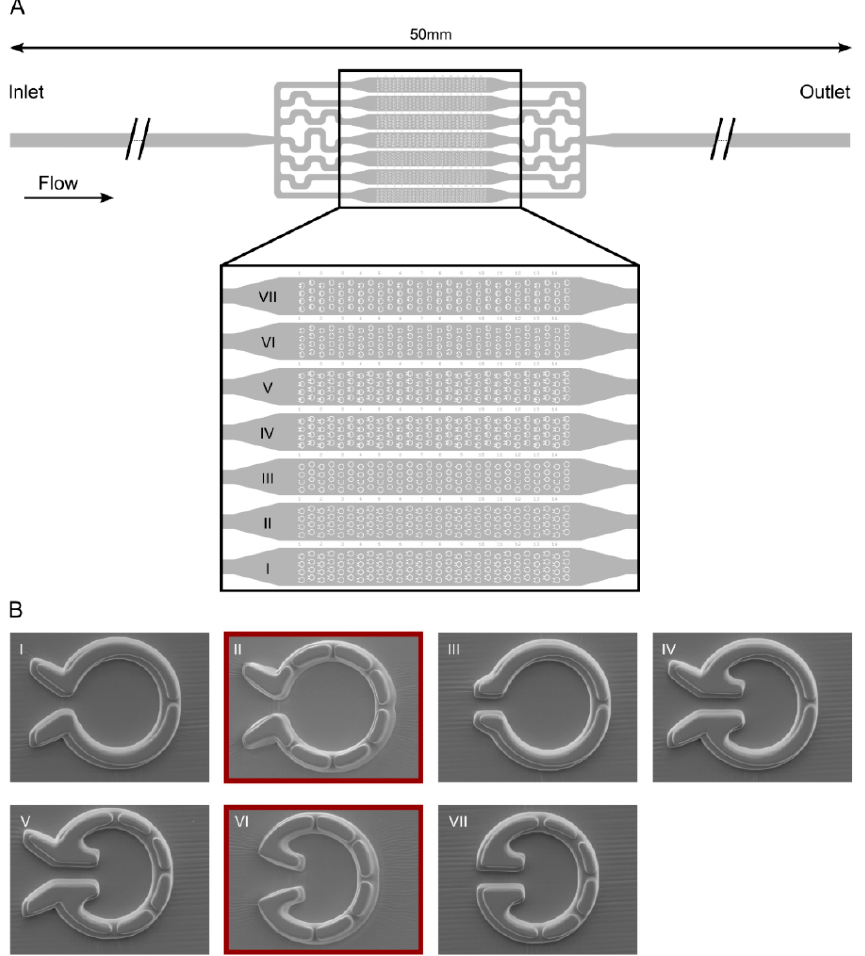
Figure 3. “Pot” microfluidics platform for capturing individual C. reinhardtii cells enabling cell division and the measurement of their photosynthetic activity. ( A ) Scheme of the device with seven different types of traps located in parallel channels. ( B ) Scanning electron microscopy images of the individual traps.